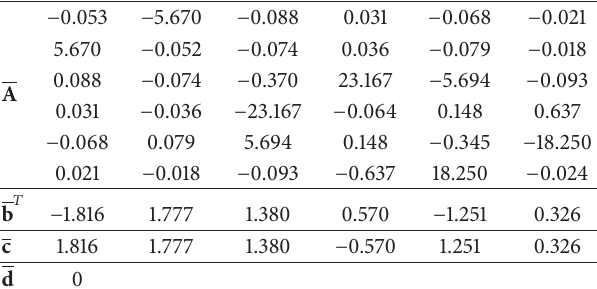
Table 11: Identification result for Case 2 .